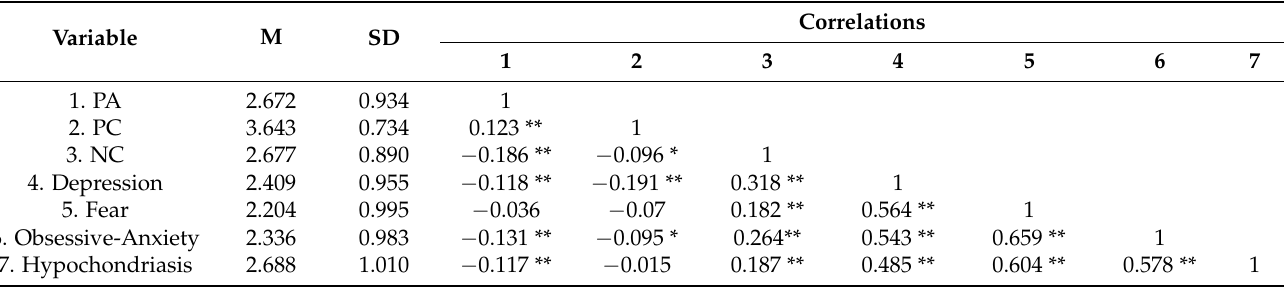
Table 1. Descriptive Statistics and